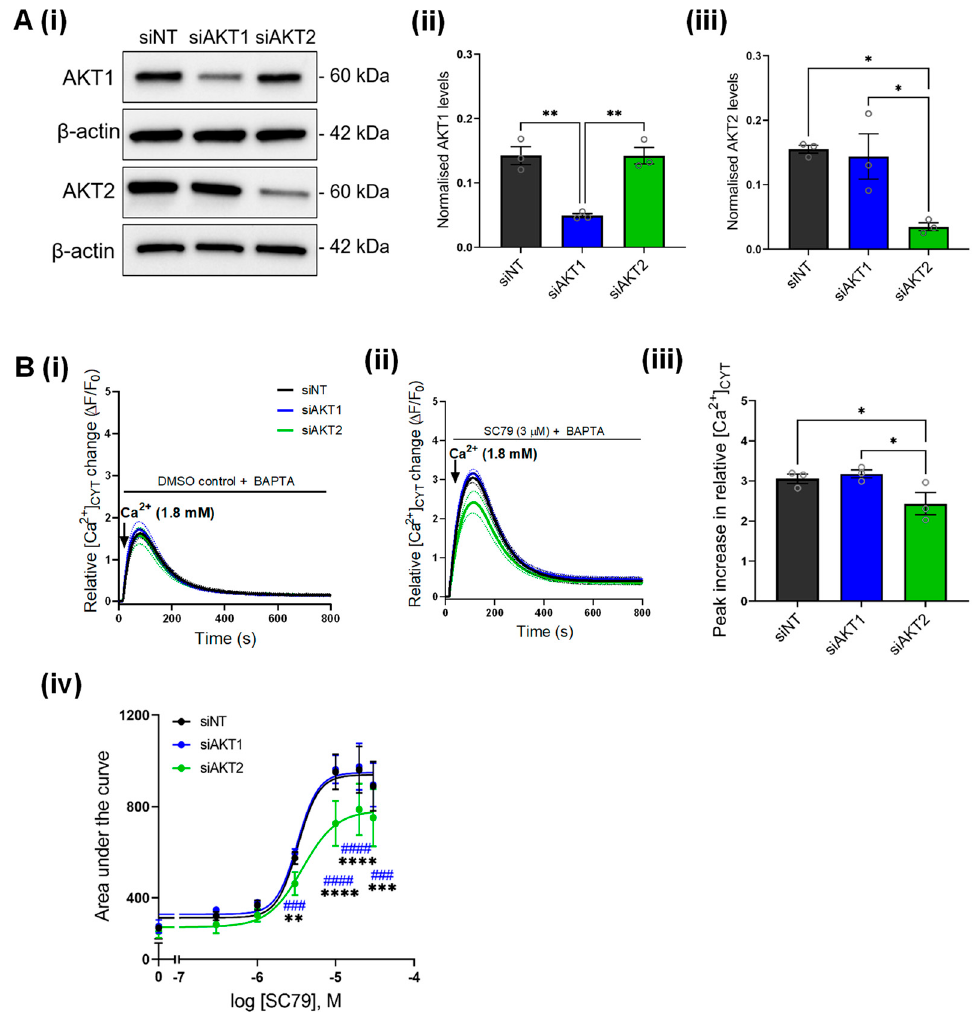
Figure 3. Effect of AKT1 and AKT2 silencing on SC79-mediated Ca 2+ influx. ( A ) (i) Immunoblot shows the protein levels of AKT1 and AKT2 with siAKT1 and siAKT2 compared to siNT control. Bar graphs show the densitometry analysis of (ii) AKT1 and (iii) AKT2 protein levels as a result of siAKT1 and siAKT2 treatment in GCaMP6m-MDA-MB-231 cells. Statistical analyses were done using a one-way ANOVA with Bonferroni’s test. ** p < 0.01, * p < 0.05. ( B ) Traces show the effect of AKT1 (siAKT1) and AKT2 (siAKT2) silencing on (i) basal Ca 2+ influx and (ii) SC79-mediated Ca 2+ influx (3 µM) in GCaMP6m-MDA-MB-231 cells. (iii) Bar graph show the mean ± S.E.M. of the peak relative Ca 2+ increase induced by SC79 (3 µM) in cells transfected with siAKT1 and siAKT2 compared to siNT. Statistical analysis was performed using a one-way ANOVA with Bonferroni’s test. * p < 0.05. (iv) Concentration-response curve comparing the effect of siAKT1 and siAKT2 on area under curve as a result of SC79-mediated Ca 2+ influx. Data points on the curves were normalized to the DMSO control for each biological replicate. Statistical analysis was performed using a repeated measures two-way ANOVA with Bonferroni’s test. * denotes statistical difference between siAKT2 and siNT; # denotes statistical difference between siAKT1 and siAKT2. **** p < 0.0001; *** p < 0.001, ** p < 0.01. Uncropped Western blots in Figure S4.